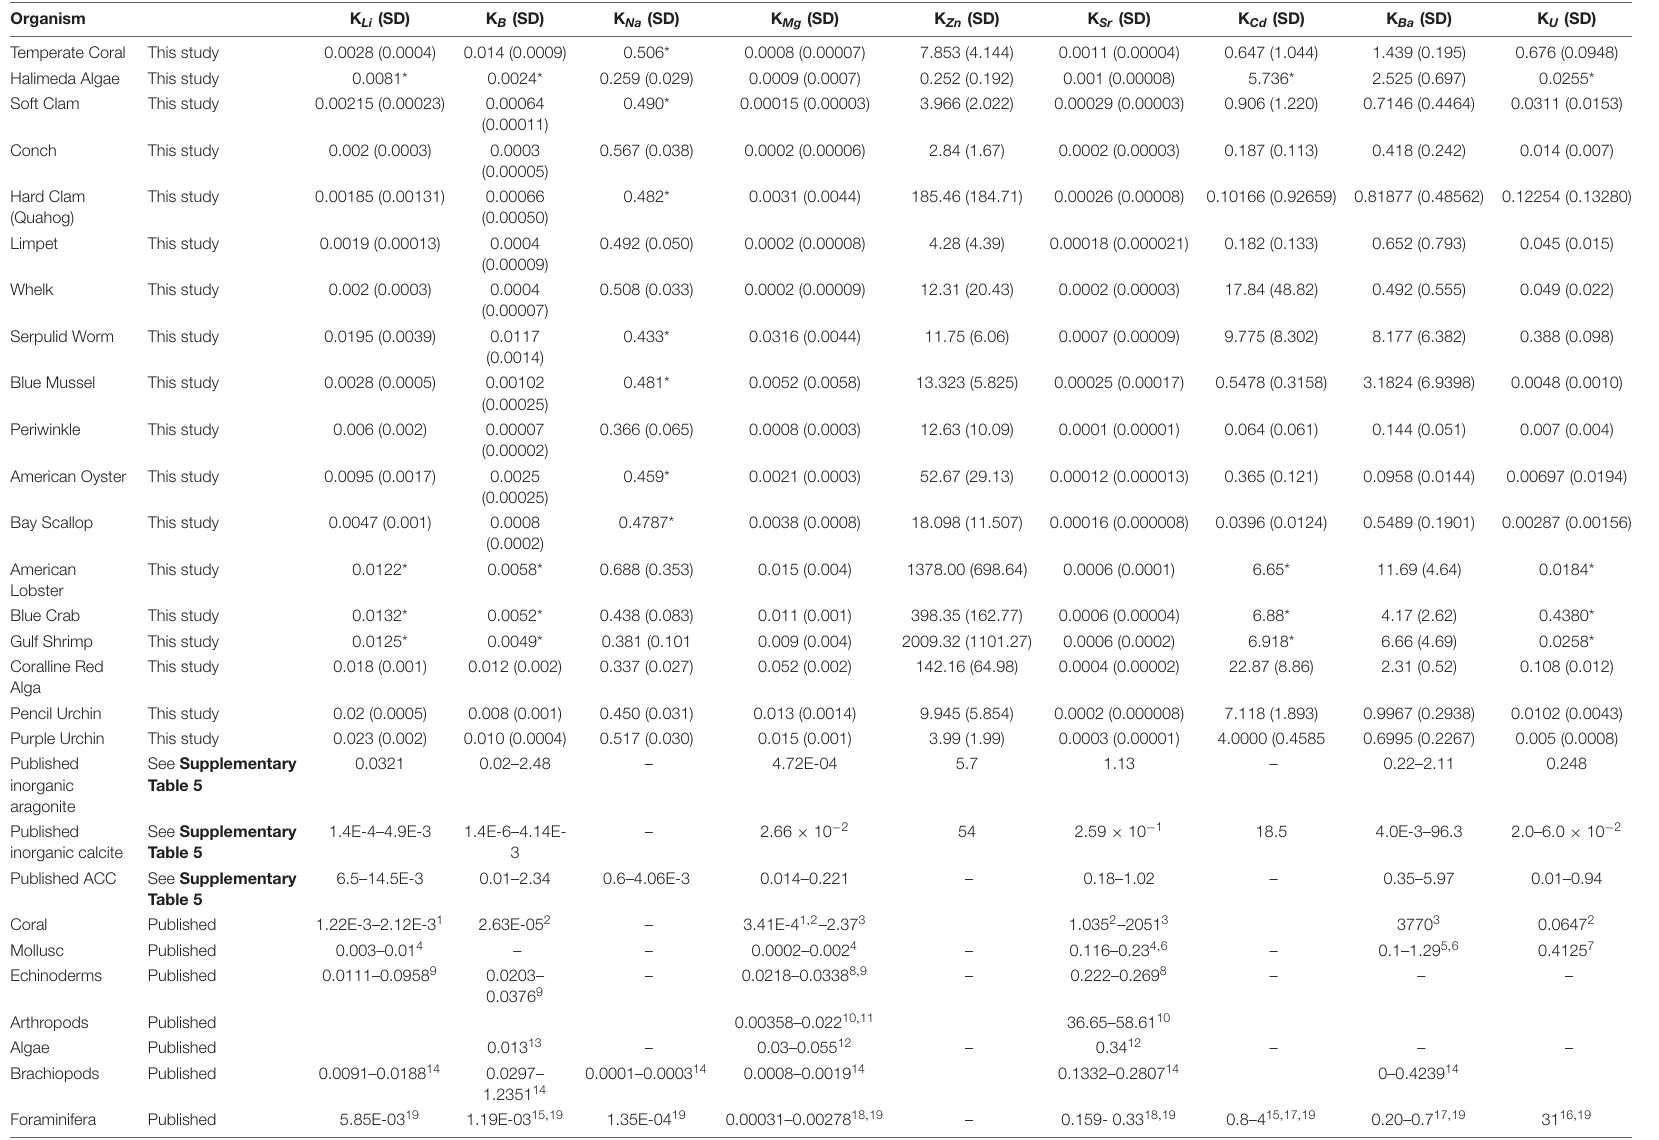
TABLE 2 | Summary of partition coefficients, including calculated apparent partition coefficients of the species cultured in this study; imputed values; synthetic calcite, aragonite, and amorphous calcium carbonate (ACC); and a number of published biogenic apparent partition coefficients.